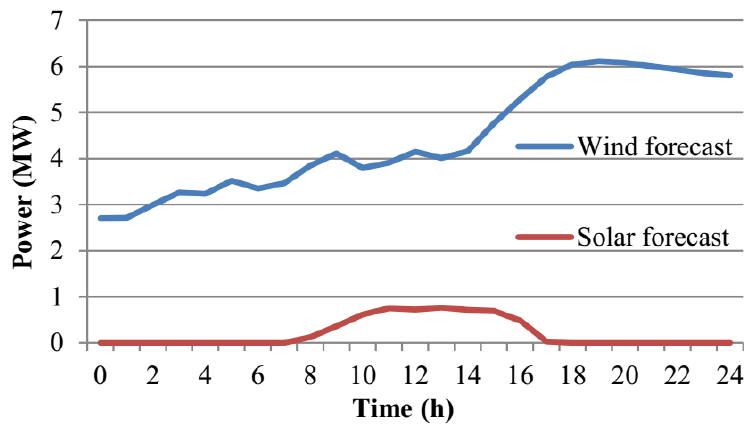
Figure 3. Winter wind power and photovoltaic power forecasts profiles in a single day of 2014. For the inclusion of the Graminhais wind farm and the theoretical expansion and an increase in the number of renewable units of the system, the corresponding scheduling is shown in Table 4. The total generation costs are $12,846.00 with a gap of 7.12%. The computational time was also acceptable, reaching the solution in 8.22 s on average.